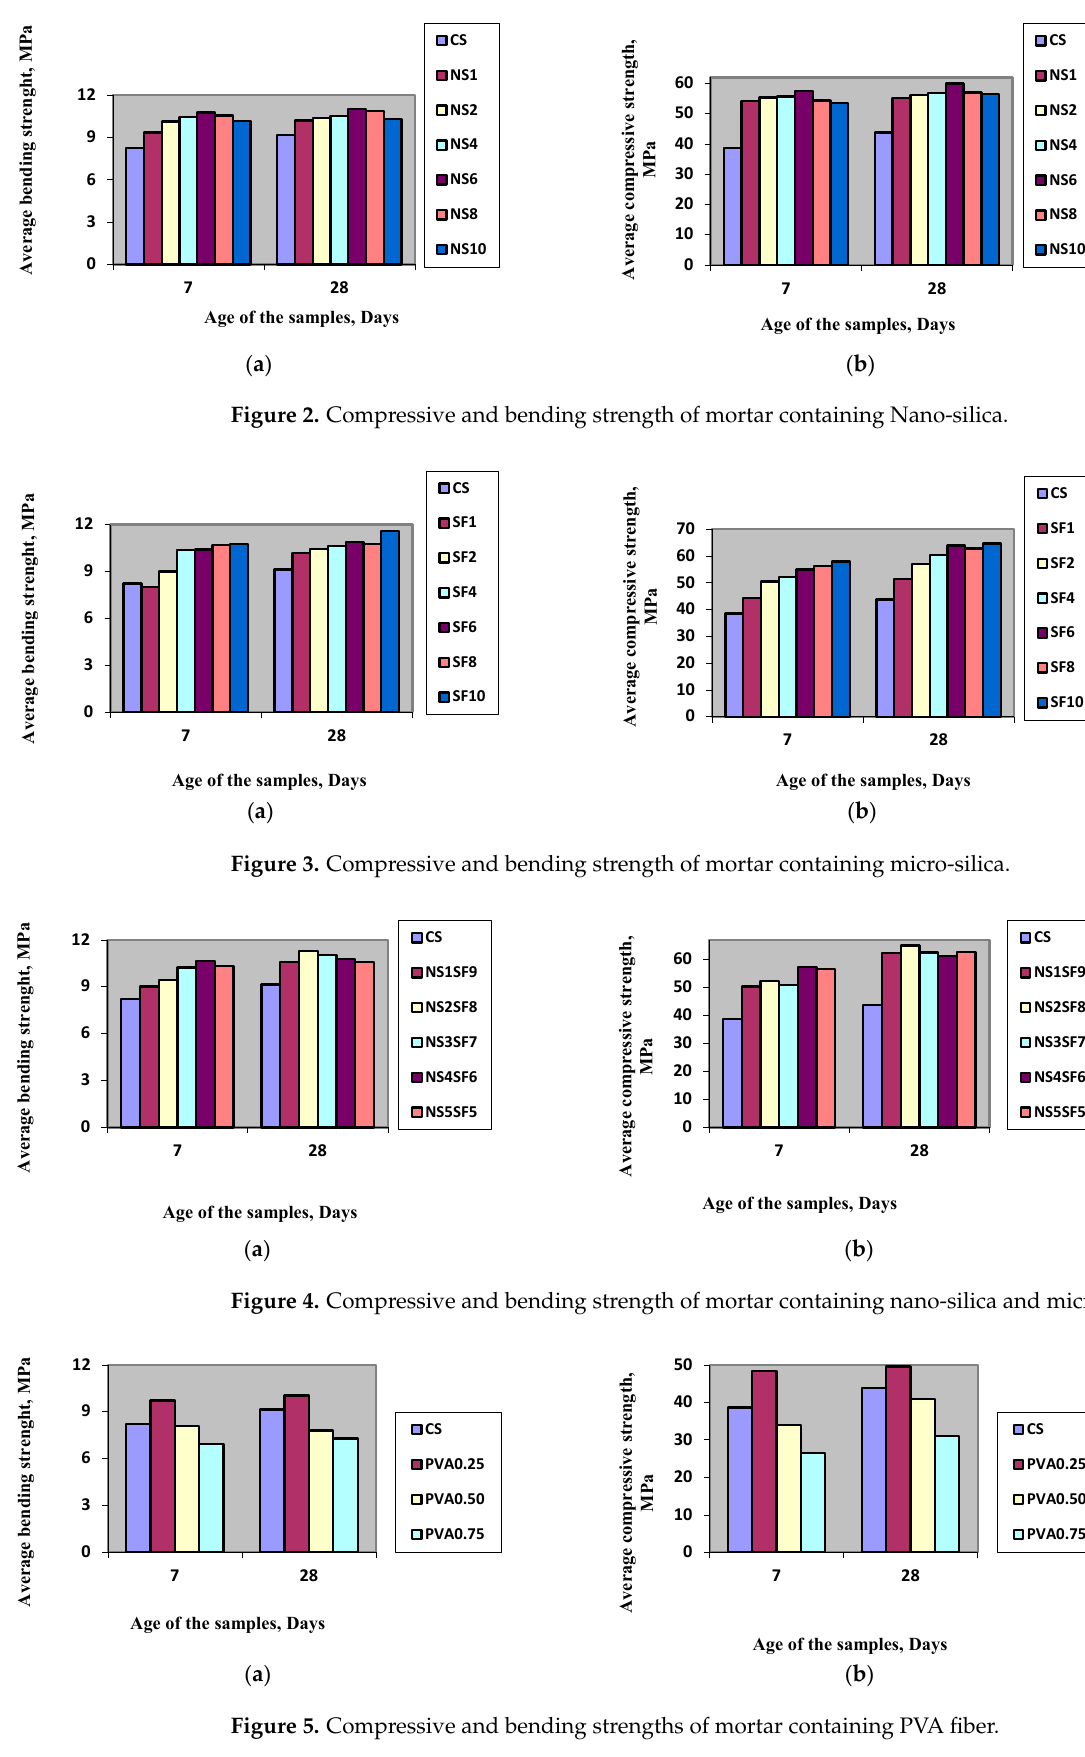
( b ) Figure 6. Compressive and bending strengths of mortar containing PVA fiber and optimum percentage of NS. ( a ) ( b ) Figure 7. Compressive and bending strengths of mortar containing PVA fiber and optimum percentage of SF.